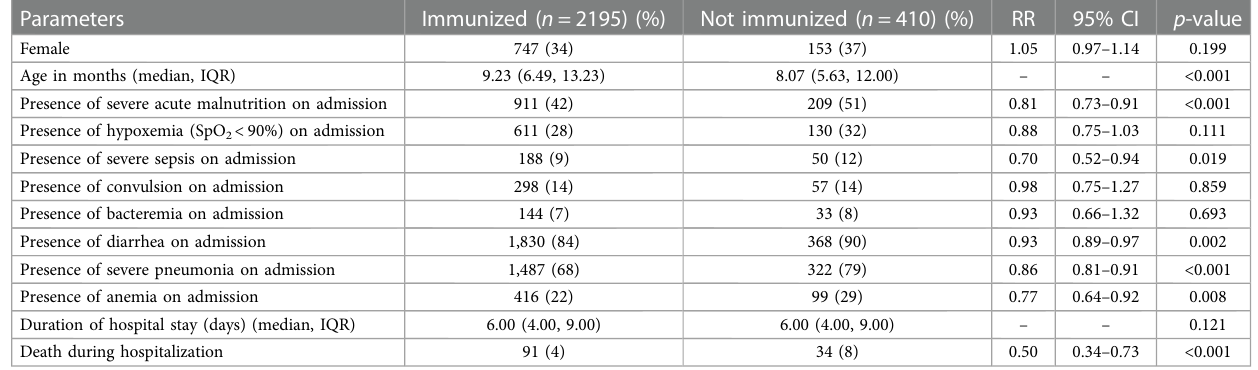
TABLE 1 Characteristics of children hospitalized for pneumonia and severe pneumonia and had immunization following EPI schedule, compared to those who were not immunized.